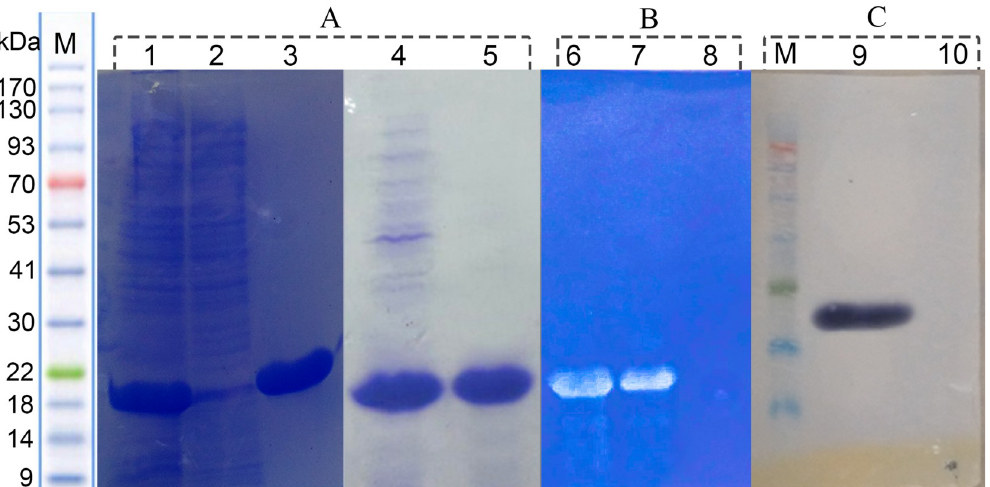
Fig 8. SDS-PAGE, western blot and zymogram analysis of recombinant protease 1147. (A) SDS-PAGE analysis of recombinant protease 1147. Lane 1 and 4) crude extract of recombinant BL21, lane2) crude extract of non-recombinant BL21 (negative control), lane 3) Ni-NTA purified, and lane 5) heat shock purified recombinant protease 1147. (B) Native-PAGE zymogram analysis of 6) Ni-NTA affinity column and, 7) heat shock single-step method purified protease 1147, 8) crude extract of non-recombinant BL21 (negative control). (C) Western blot analysis of (9) Ni-NTA affinity column purified protease 1147, and (10) negative control.